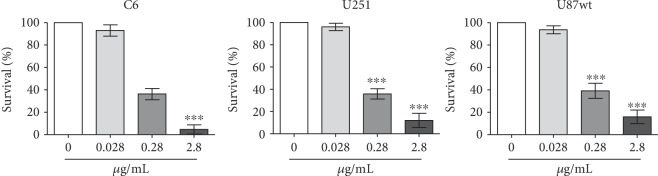
The clonogenic capacity of human glioblastoma (U87 and U251) and rat glial tumor C6 cell lines treated for 72 h with DPDT. Data are reported as means ± SD of three independent experiments. Significantly different at ∗p < 0.05, ∗∗p < 0.01, and ∗∗∗p < 0.001 compared with untreated control cells (one-way ANOVA followed by Tukey test).